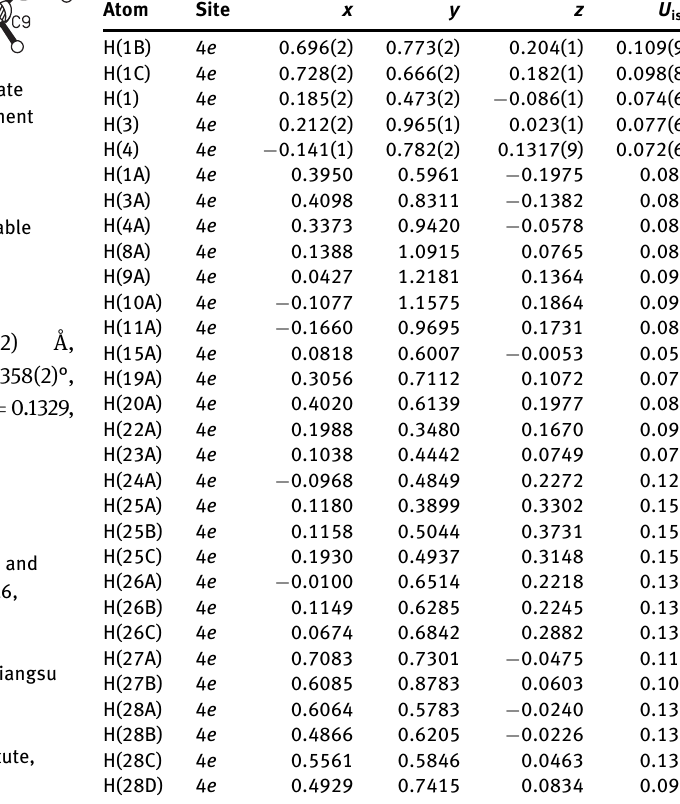
Table 2: Atomic coordinates and displacement parameters (in Å 2